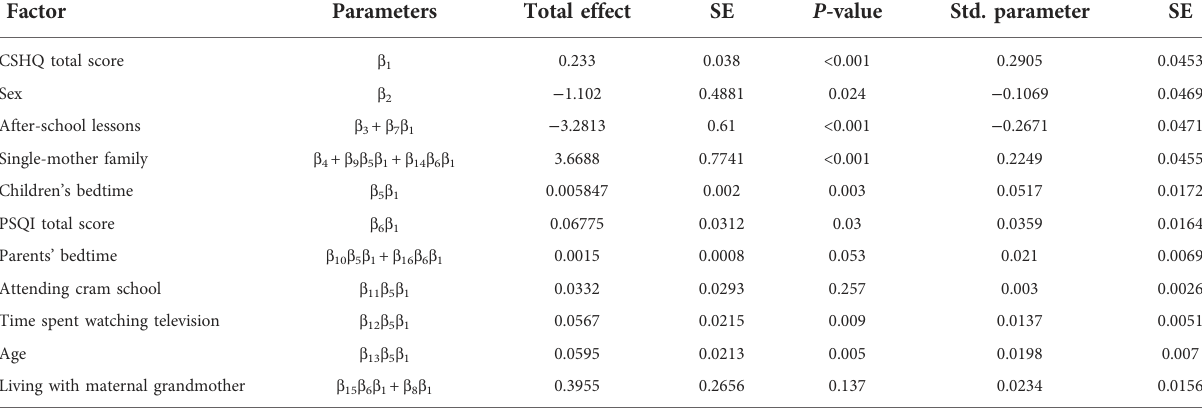
TABLE 6 Total effects and standardized parameters of factors on the SDQ total score.